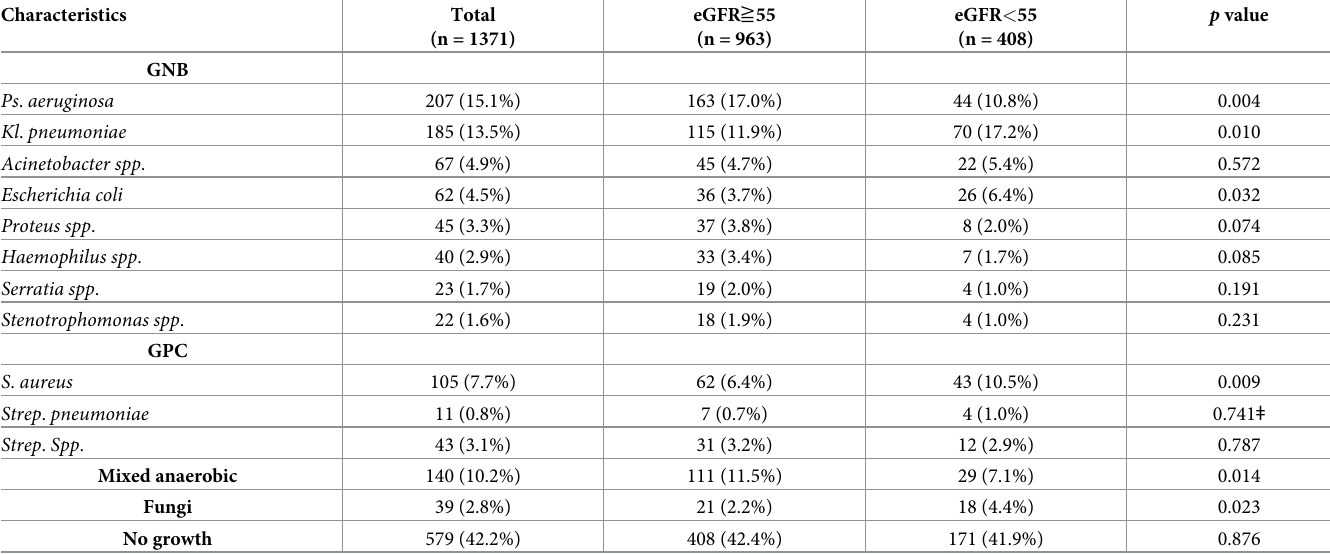
Table 2. Sputum microbiological analysis of patients hospitalized with pneumonia categorized by eGFR.